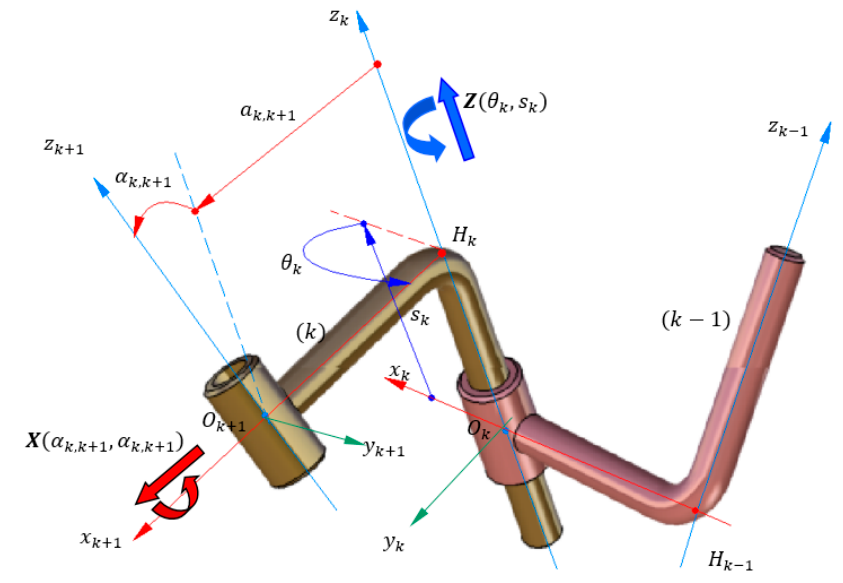
Figure 3. The Hartenberg–Denavit convention.